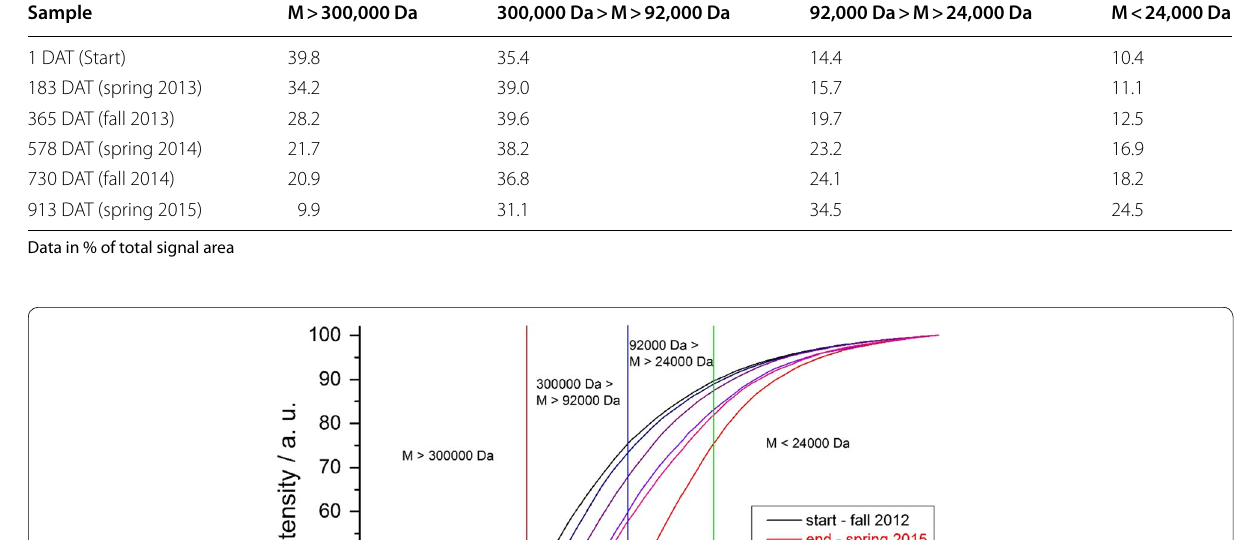
Table 2 Molar mass distribution in lysimeter soil extracts determined by GPC based on reference standards